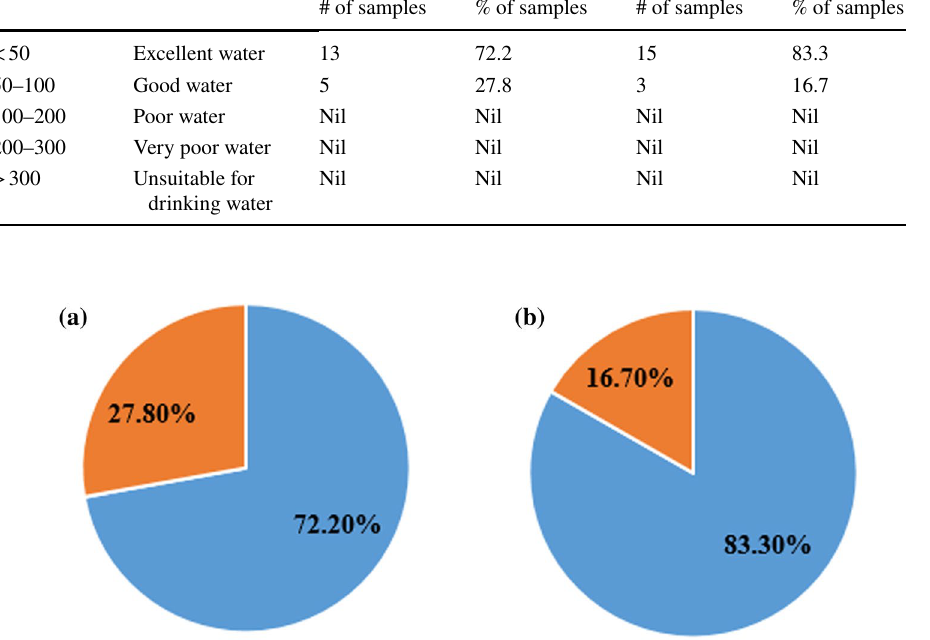
classification of WQI for drinking purpose in the present